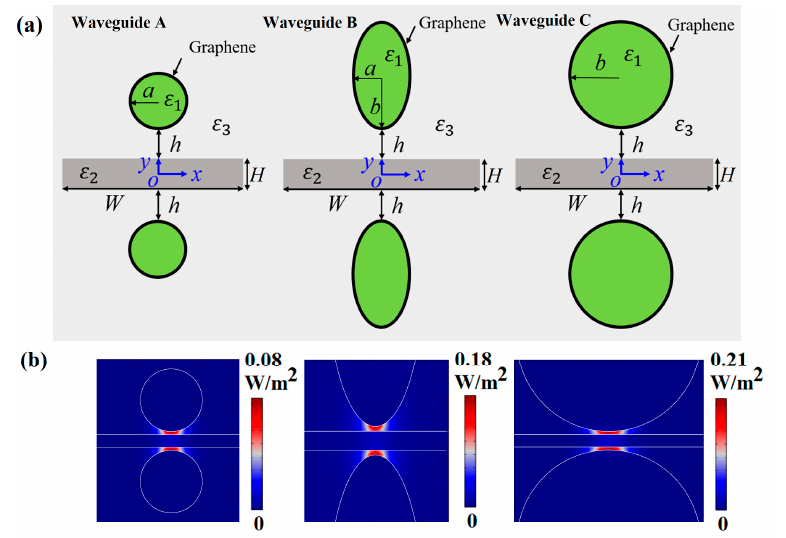
Figure 8. Comparison of three SGPWGs. ( a ) Cross-section of Waveguide A ( R = a = 50 nm), B ( a = 50 nm, b = 150 nm), and C ( R = b = 150 nm); ( b ) 2D energy density distributions of ( a ). Table 1. Waveguiding performance comparison of three